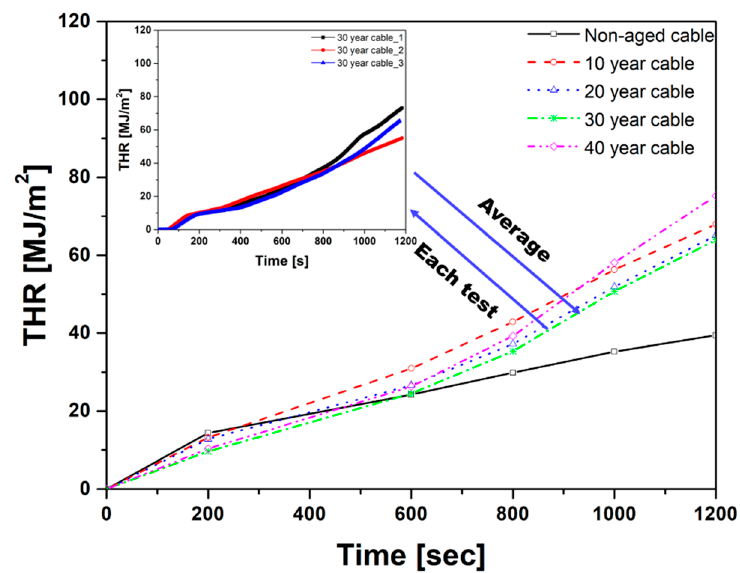
Figure 7. Time series total heat release (THR) with respect to the accelerated aging periods.